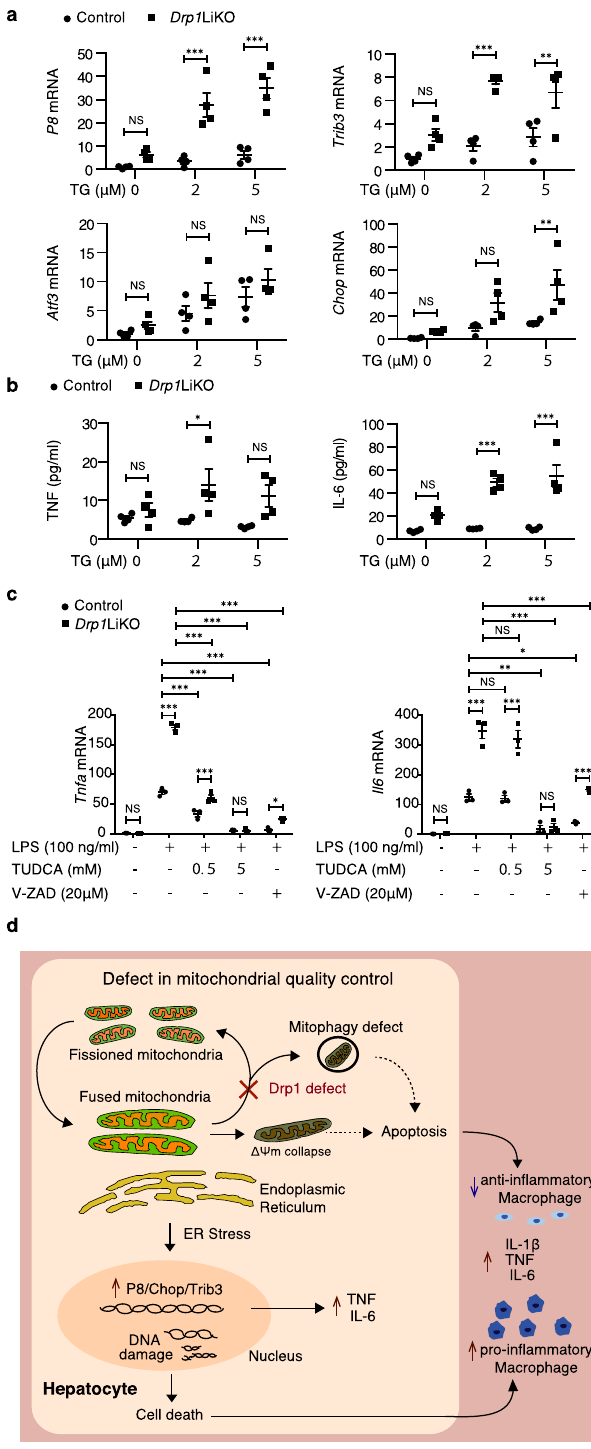
Table 5 lists the primer sequences of the selected genes. We normalized relative gene expression versus control to Gapdh